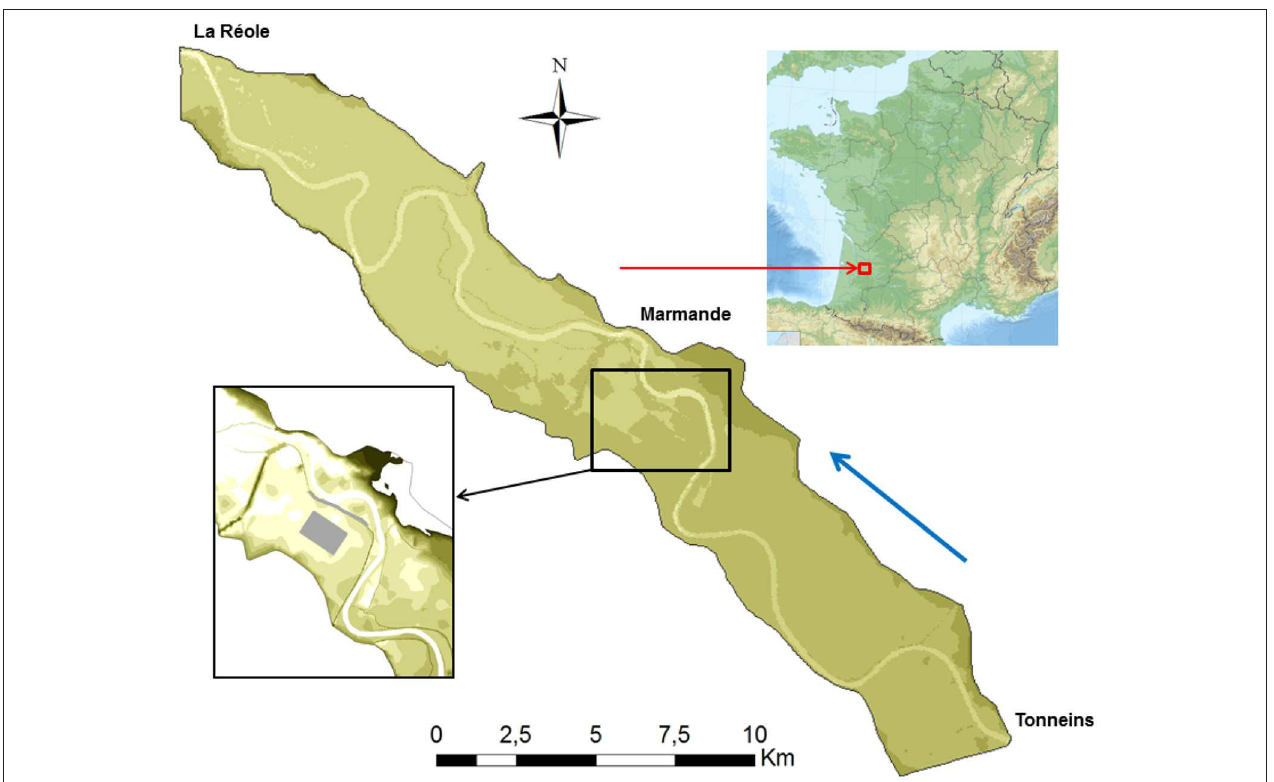
FIGURE 1 | Location and span of the modeled study area on the Garonne river including the location of the industrial site (gray surface) and the protection (gray line) requiring modification to meet the safety